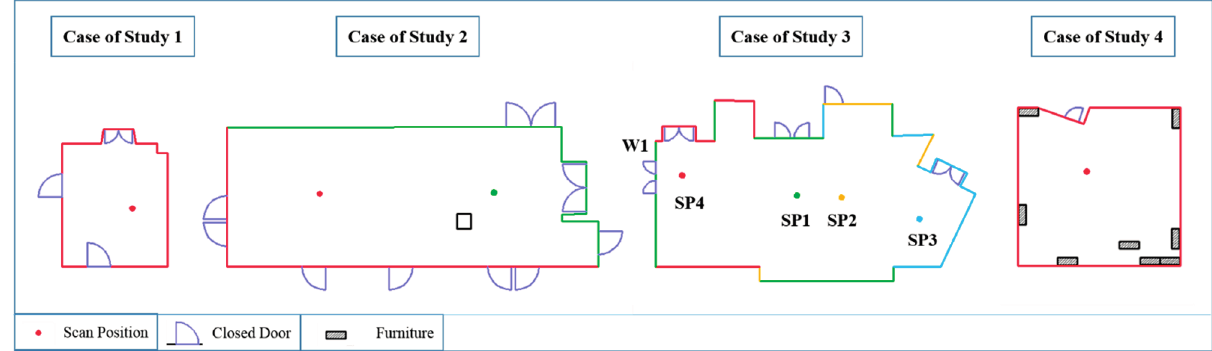
Figure 13. Scan Position selection for each wall according to the angle prioritizing and pixel-visibility test.